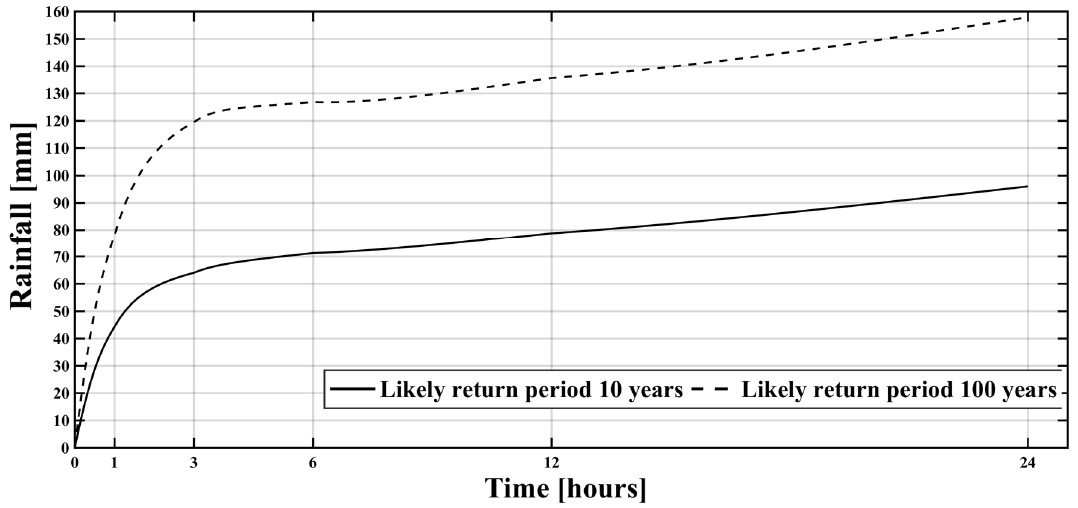
Figure 3. Intensity–duration curve from hourly rainfall records at the rain gauge located in Borgo San Michele station (Lat. 41 ◦ 25 (cid:48) 12 (cid:48)(cid:48) N Lon. 12 ◦ 58 (cid:48) 12 (cid:48)(cid:48)